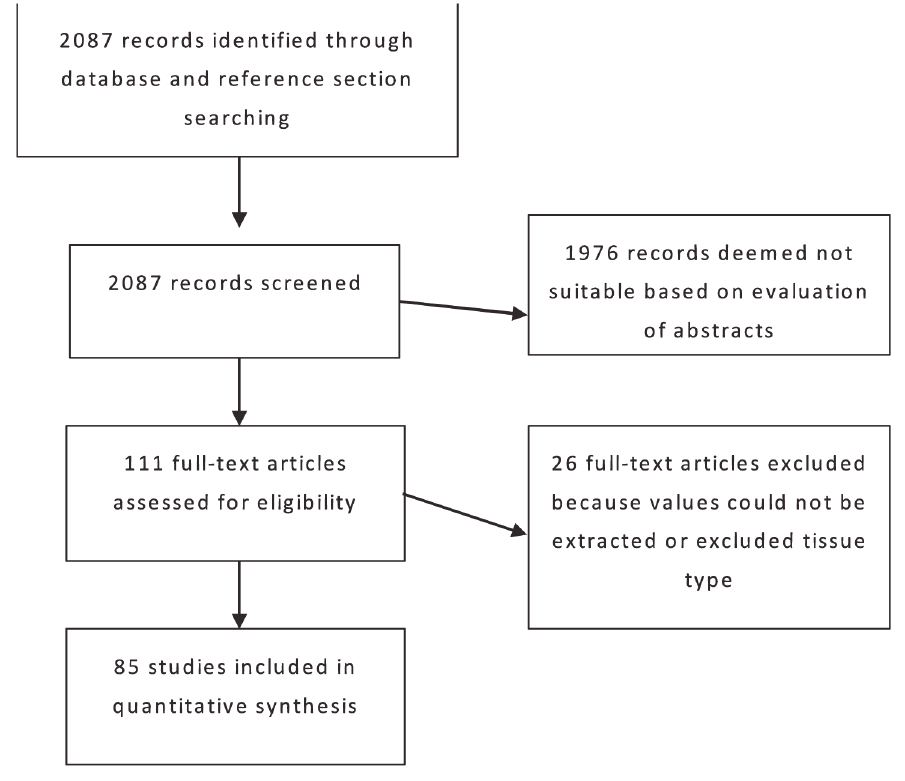
Fig 1. Flow diagram of manuscript screening and eligibility for this literature